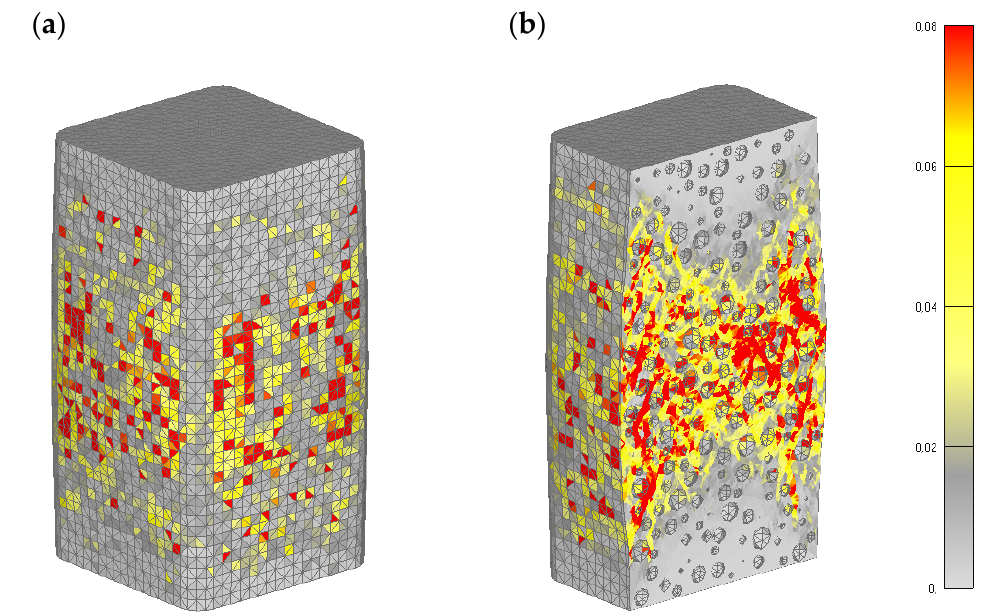
Figure 12. Typical failure mode R 15: ( a ) concrete damage and ( b ) internal distribution of damage in mortar (maximum principal strains).